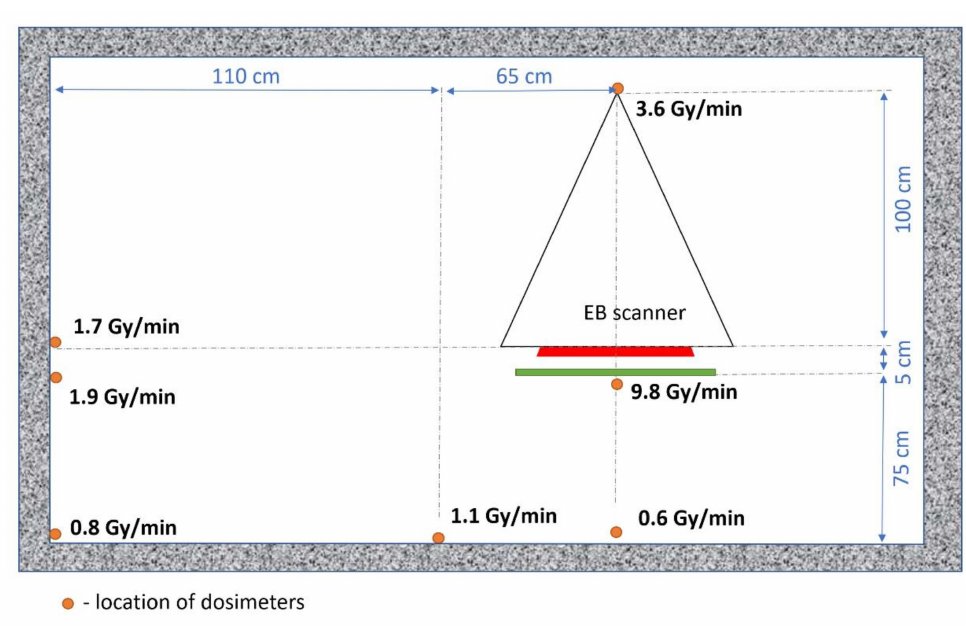
Figure 7. Measured dose rate in different positions of irradiation chamber, side